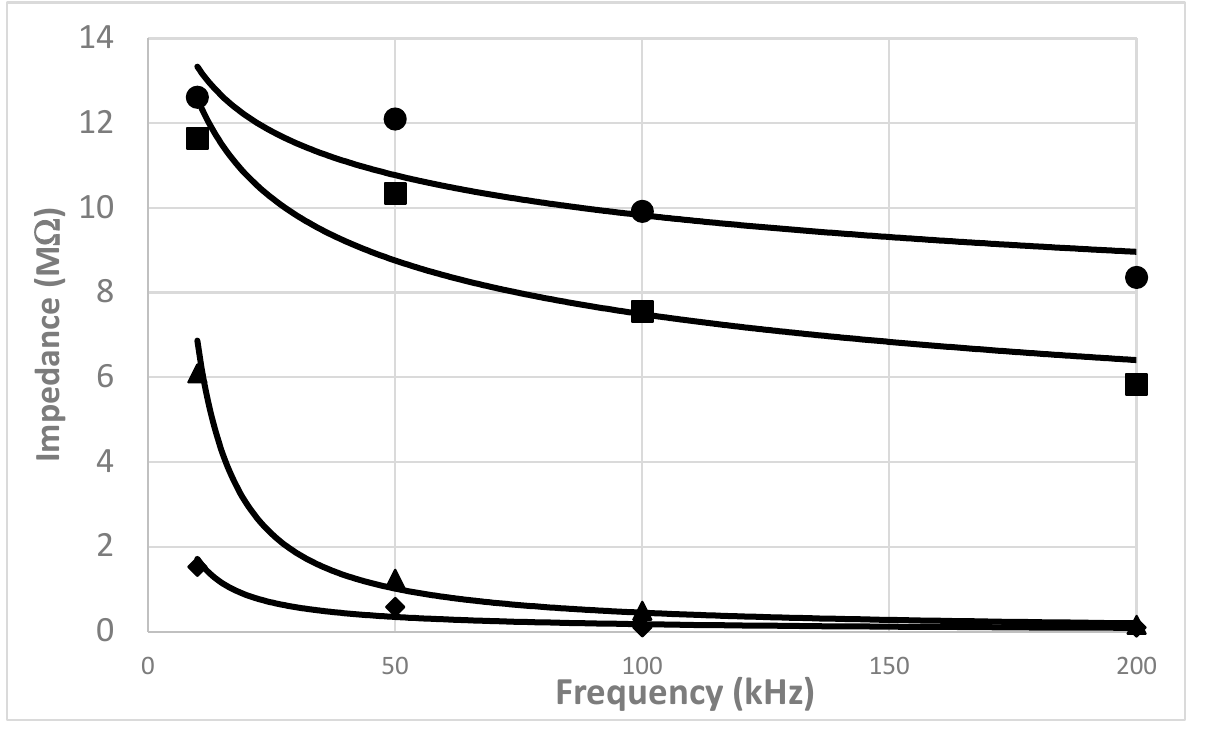
Figure 4. Frequency dependency of impedance for all samples: ● , control; ■ , with nettle; ▲ , with carrot; ♦ , with elderberry. characteristics in a complex variable through a transfer function G ( s ) in the shape